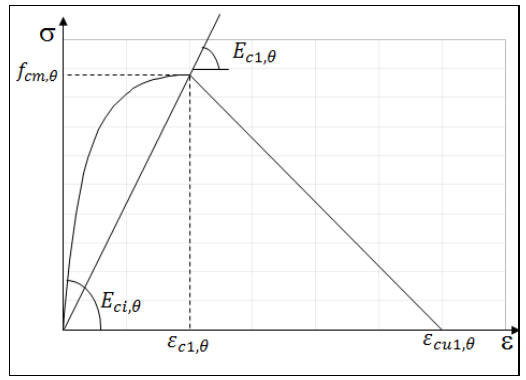
Figure 5. Generic concrete constitutive relation under compression in function of the